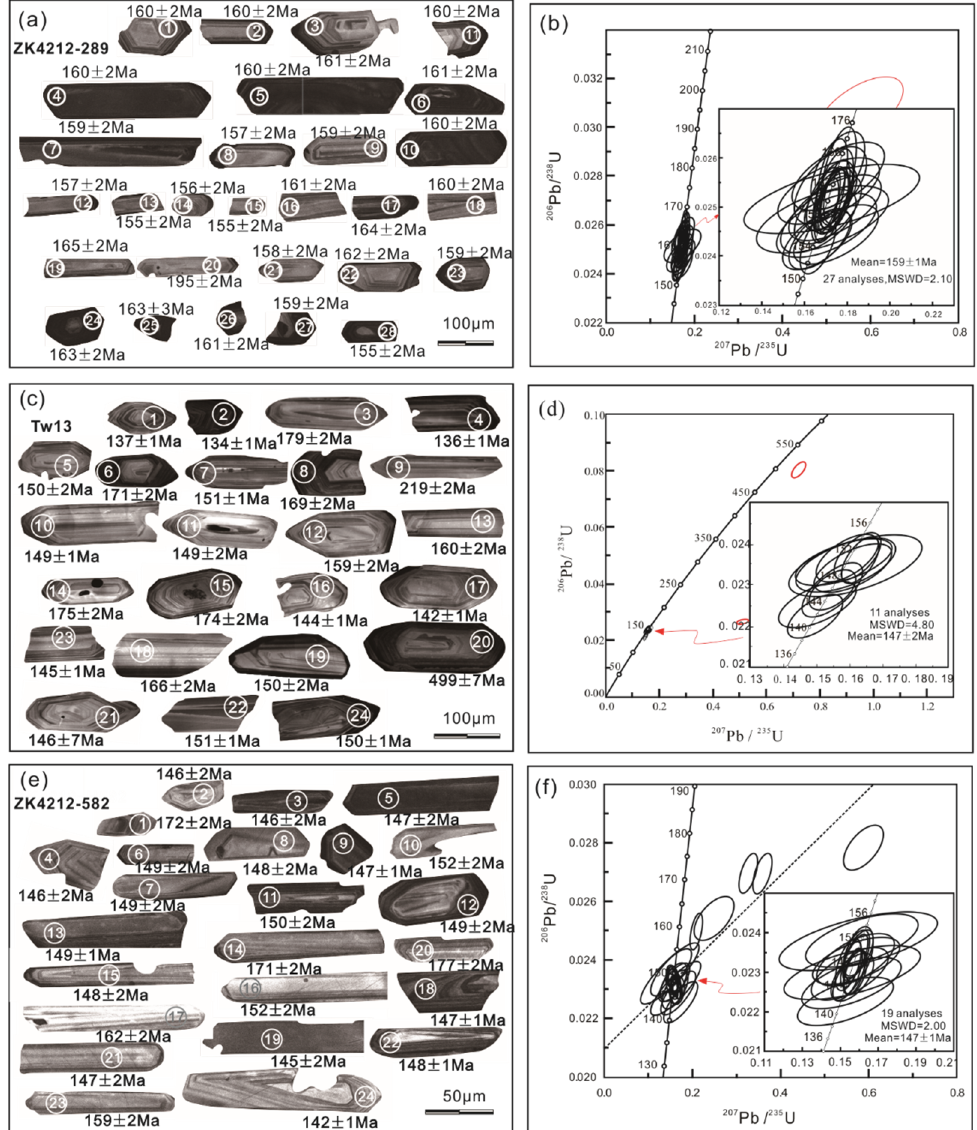
Figure 4. CL images, analytical sites, spot ages, and U–Pb Concordia diagram for Zhuxi granites in the Jingdezhen area; granodiorite Zk4212-289 ( a , b ), biotite granite Tw13 ( c , d ) two-mica granite Zk4212-582 ( e , f ).